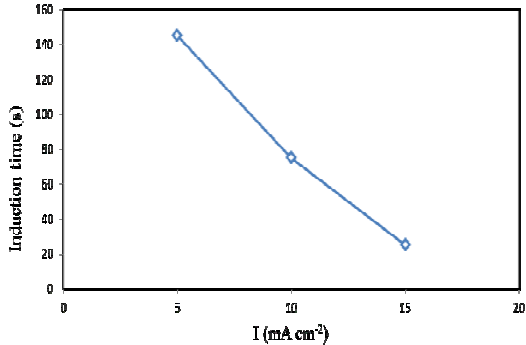
Fig 2 . Induction times for applied current